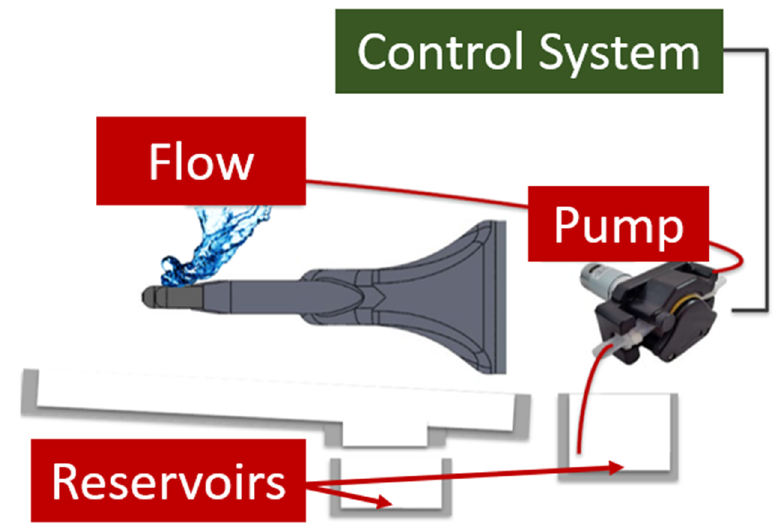
Figure 12. Diagram of the connections between the hand, liquid pump, and control system.